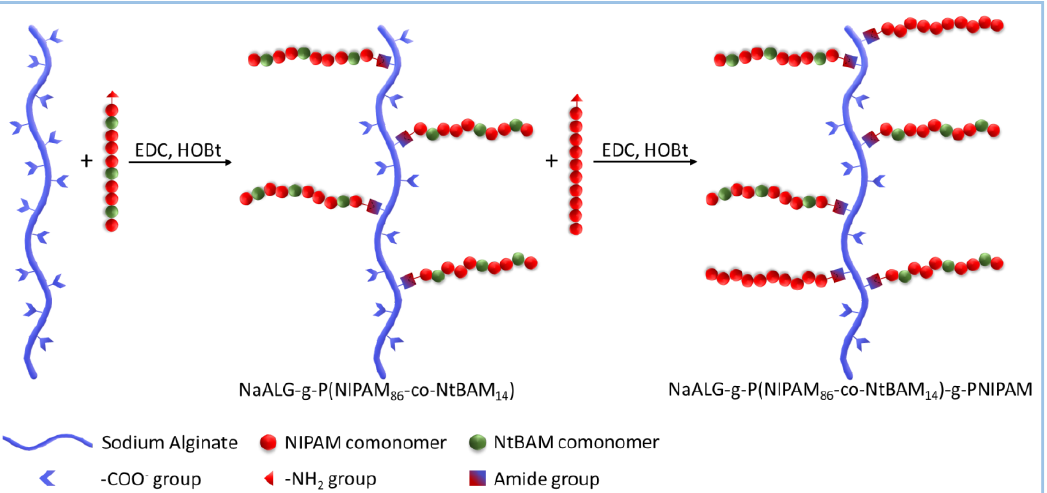
Figure 1. Schematic representation of the heterografting reaction. First step: synthesis of the ALG-g-P(NIPAM 86 - co -NtBAM 14 ) graft copolymer; second step: the ALG-g-P(NIPAM 86 - co -NtBAM 14 ) graft copolymer was grafted by the NH 2 -PNIPAM homopolymer, yielding the final ALG/HGC hetero- graft copolymer. Table 1. Molecular characteristics of ALG/HG copolymer.